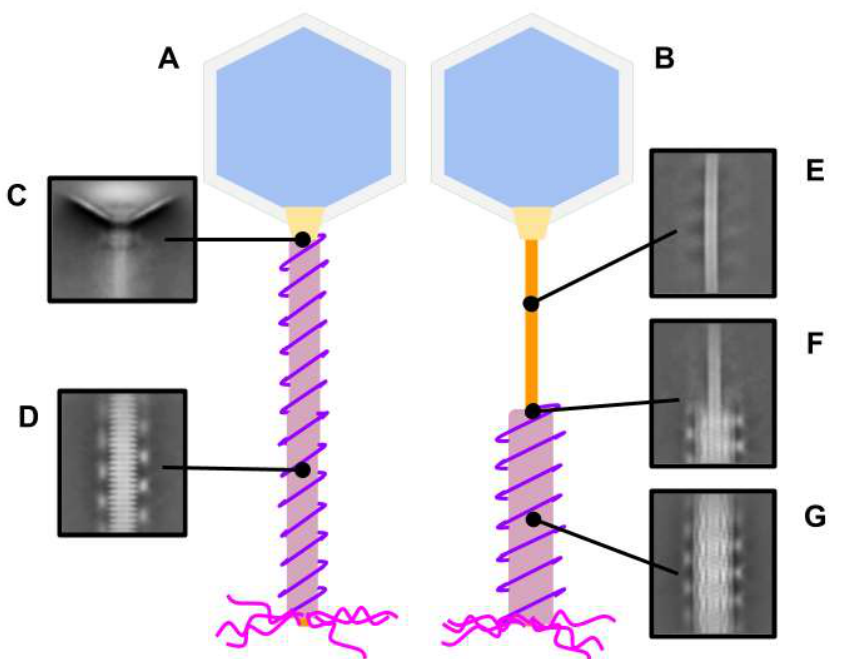
Figure 3. 2D classification of phage G tail components. The cartoons above represent the non-contracted ( A ) and contracted ( B ) tail sheath states of phage G. The small insets are 2D classifications from the cryo-EM data that point to the corresponding tail components in the cartoons as follows: ( C ) neck region; ( D ) non-contracted sheath; ( E ) tube; ( F ) contracted sheath and tube junction; ( G ) contracted sheath.